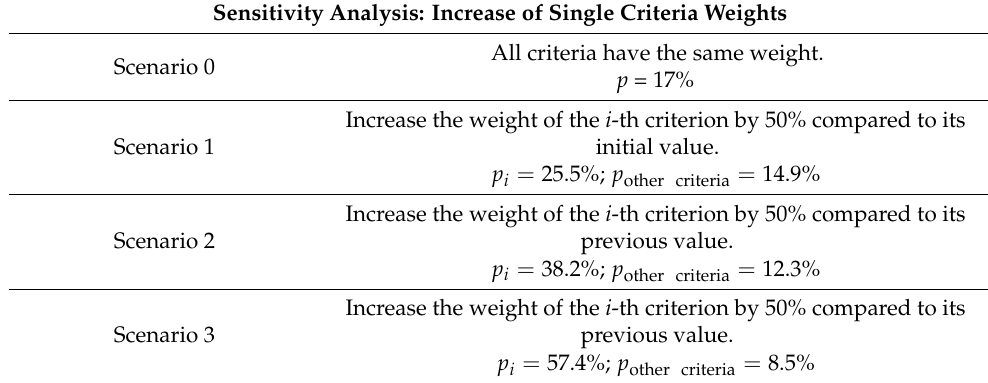
Table 3. Sensitivity analysis on the weights of the